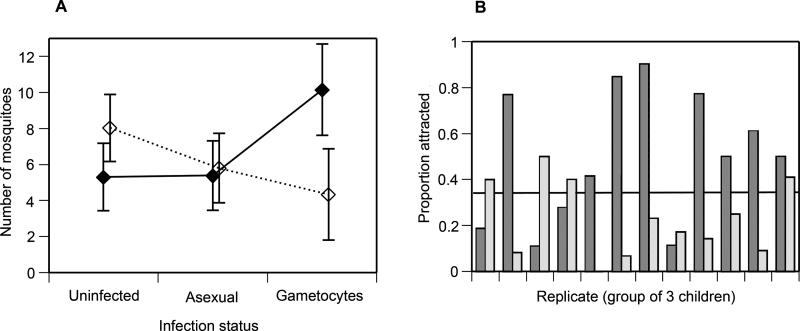
Graphical Representation of Results(A) Number of mosquitoes attracted to each class of children. Points show means of 12 groups; vertical lines show standard errors of the means. Solid diamonds show data of children before treatment; open diamonds denote children after treatment.(B) Proportion of the responsive mosquitoes (i.e., the ones that were attracted to any of the children within a group) attracted to the children who harboured gametocytes (before treatment; dark bars) and to the children who had cleared their gametocytes (after treatment; light bars). The horizontal line shows the proportion expected if the mosquitoes showed no preference.